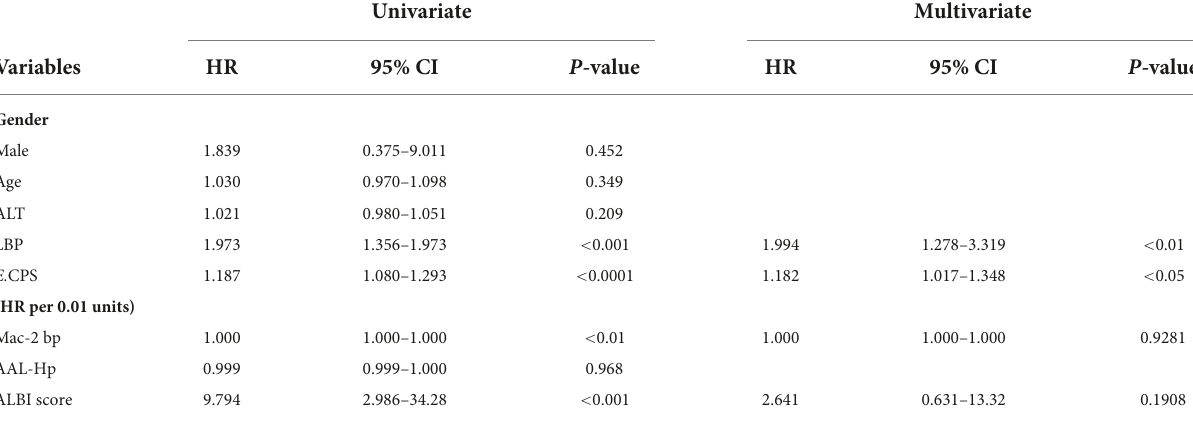
TABLE 3 Univariate and multivariate Cox regression analysis for predictors of survival in chronic liver disease patients.